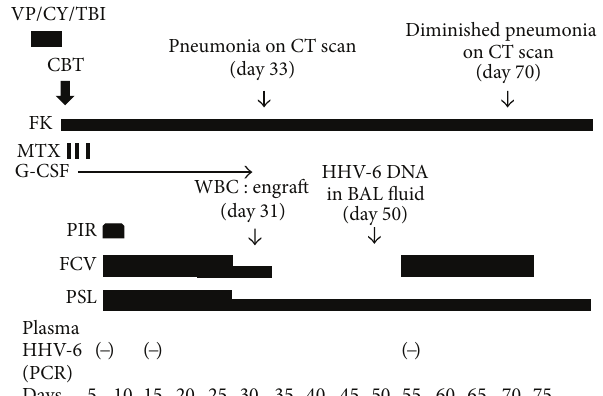
Figure 1: Clinical course of the present case. VP: etoposide, CY: cyclophosphamide, TBI: total body irradiation, CBT: cord blood transplantation, FK: tacrolimus, MTX: methotrexate, G-CSF: granulocyte colony-stimulating factor, PIR: preengraftment immune reaction, WBC: white blood cell, BAL: bronchoalveolar lavage, FCV: foscarnet, and PSL: prednisolone.